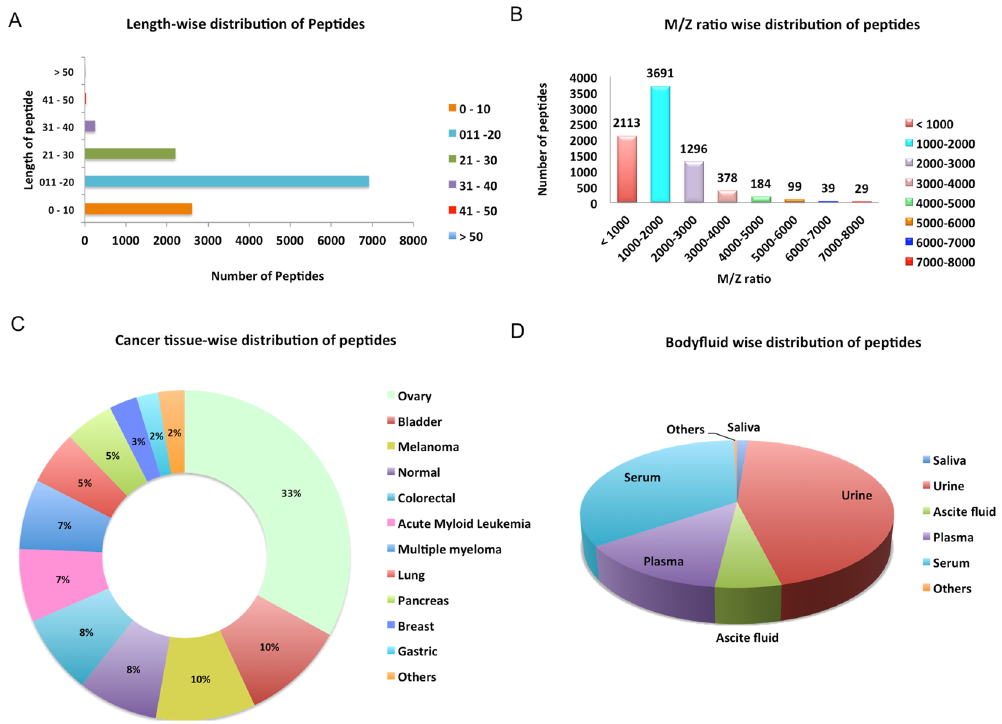
Figure 2. Distribution of peptides according to length ( A ), mass range ( B ), cancer tissue types ( C ) and biofluids ( D ) in CancerPDF database.